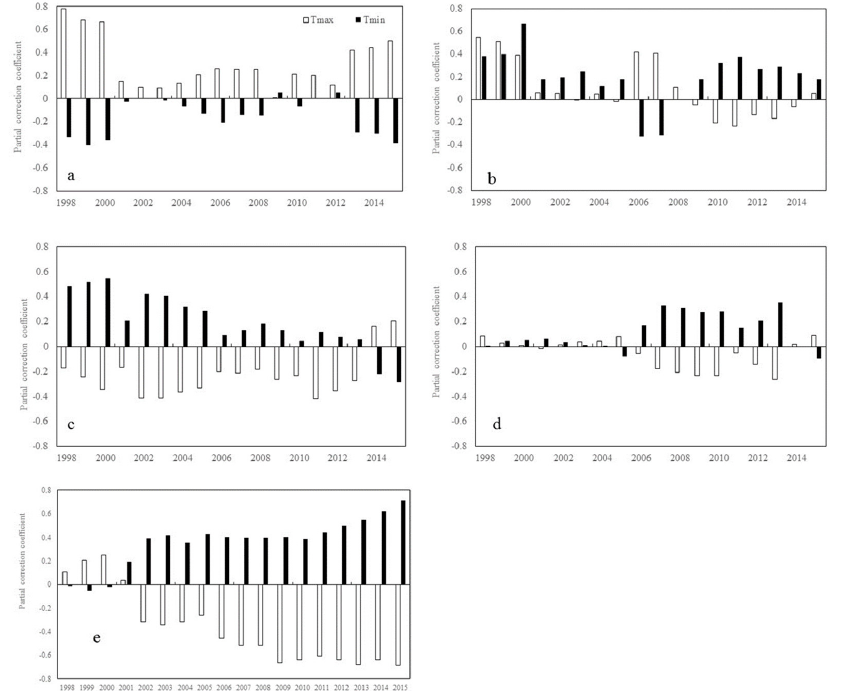
Figure 2. Temporal variations in the partial correlation coefficients between mean NDVI and the diurnal temperature (T max and T min ) in spring for each 17-year moving window across latitudes intervals. ( a – e represents latitudes intervals at 60 ◦ ~90 ◦ N, 30 ◦ ~60 ◦ N, 0 ◦ ~30 ◦ N, − 30 ◦ ~0 ◦ S, and − 60 ◦ ~0 ◦ S, respectively (N and S indicates the Northern and southern hemisphere, respectively). The x axis is the last year of the 17-year moving-window (for example, 1998 stands for a moving-window from 1982 to 1998, . . . , 2015 stands for a moving-window from 1999 to 2015). The Y axis is the partial correlation coefficients). During summer, R NDVI-Tmax shows a significant downward trend not only at the low latitudes in the northern hemisphere ( β = − 0.020, p < 0.05), but also at the low and mid- latitudes in the southern hemisphere ( β = − 0.029, p < 0.05) (Fig.3). R NDVI-Tmin shows a signif- icant downward trend ( β = − 0.022, p < 0.05) at the high latitudes in the northern hemi- sphere, but a significant upward trend ( β = 0.023, p < 0.05) at the mid-latitudes in the southern hemisphere (Figure 3).